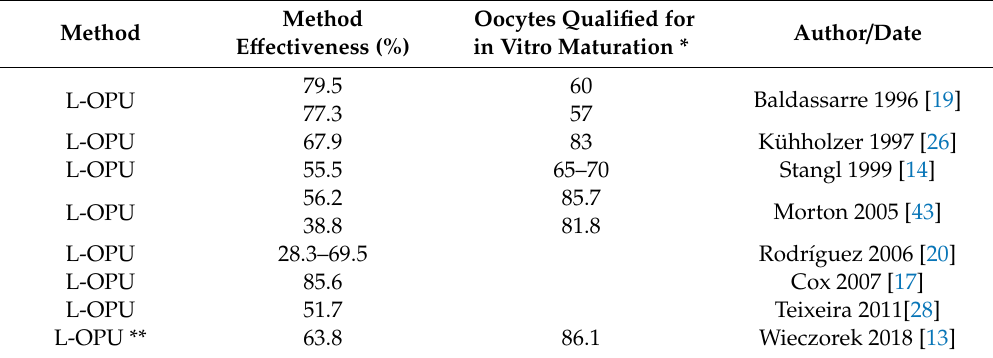
Table 4. Comparison of e ff ectiveness of oocyte recovery using the ovum pick-up method in